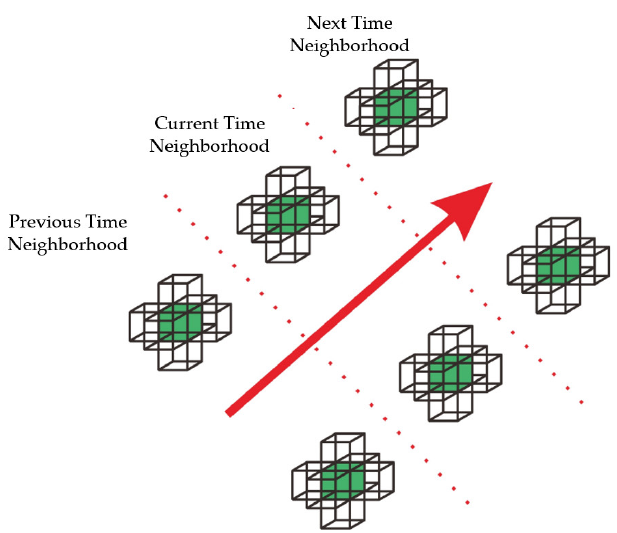
Figure 4. Schematic diagram of spacetime neighborhood. Algorithm 5: Algorithm of XY plane spacetime eight neighborhoods.